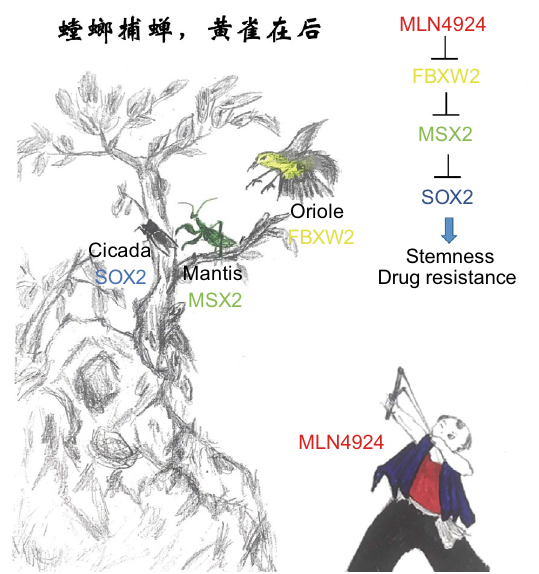
Figure 1. A negative cascade of the FBXW2 – MSX2 – SOX2 axis is targeted by MLN4924. SOX2 (cicada) is a transcriptional downstream target of MSX2 (mantis). Upon binding to SOX2 gene promoter, MSX2 negatively controls SOX2 transcription. MSX2, on the other hand, is a substrate of FBXW2 (oriole) E3 ligase. Upon hypoxia, FBXW2 binds to MSX2 and targets it for ubiquitylation and subsequent degradation. lation to transcriptionally repress